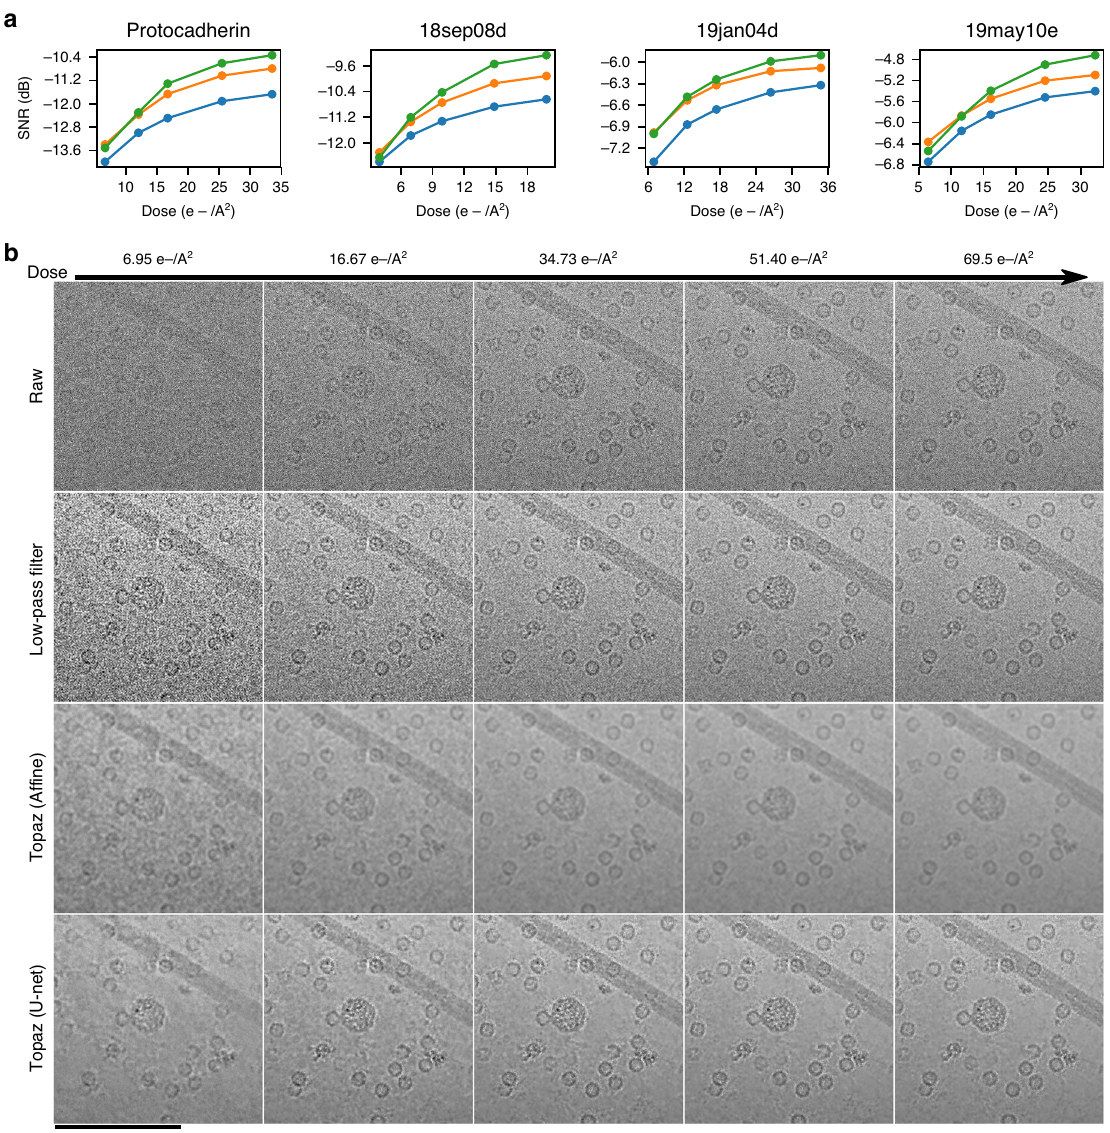
Fig. 3 Denoising with the general model in Topaz enhances SNR of short exposure micrographs. a SNR (dB) calculated using the split-frames method (see Methods) as a function of electron dose in low-pass fi ltered micrographs by a binning factor of 16 (blue), af fi ne denoised micrographs (orange), and U-net denoised micrographs (green) in the four NYSBC K2 datasets. Our U-net denoising model enhances the SNR of micrographs across almost all dosages in all four datasets. U-net denoising enhances SNR by a factor of 1.5× or more over low-pass fi ltering at 20 e-/A 2 . b Example section of a micrograph from the 19jan04d dataset of apoferritin, β -galactosidase, a VLP, and TMV (full micrograph in Supplementary Figs. 3 and 4) showing the raw micrograph, low-pass fi ltered micrograph, af fi ne denoised micrograph, and U-net denoised micrograph over increasing dose. Particles are clearly visible at the lowest dose in the denoised micrograph and background noise is substantially reduced by Topaz